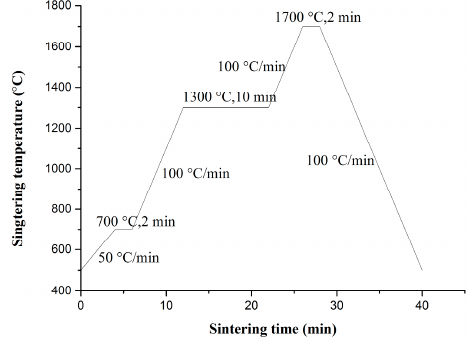
Figure 1. Temperature pro fi le of the spark plasma sintering (SPS) process.